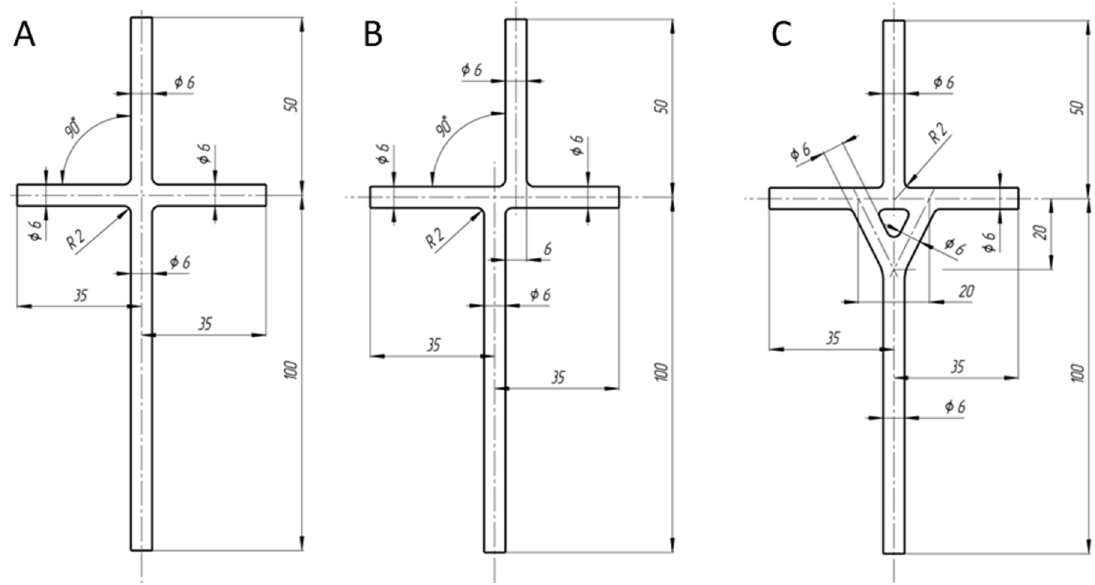
Figure 1. Schematic of three different geometry configurations of total cavopulmonary connections (TCPCs) chosen for the research in this work. ( A ) Simple direct joint, where the inferior vena cava (IVC) and superior vena cava (SVC) are coaxially arranged (model is shown with dimensions). ( B ) Compound where the IVC and SVC are shifted by the distance of a single diameter (6 mm). This type of compound is often used in TCPC surgery. ( C ) More complex type of curvilinear connection, where IVC is divided into two vessels and connected to the left pulmonary artery (LPA) and right pulmonary artery (RPA) at an angle, directing the flow along a smoother trajectory.